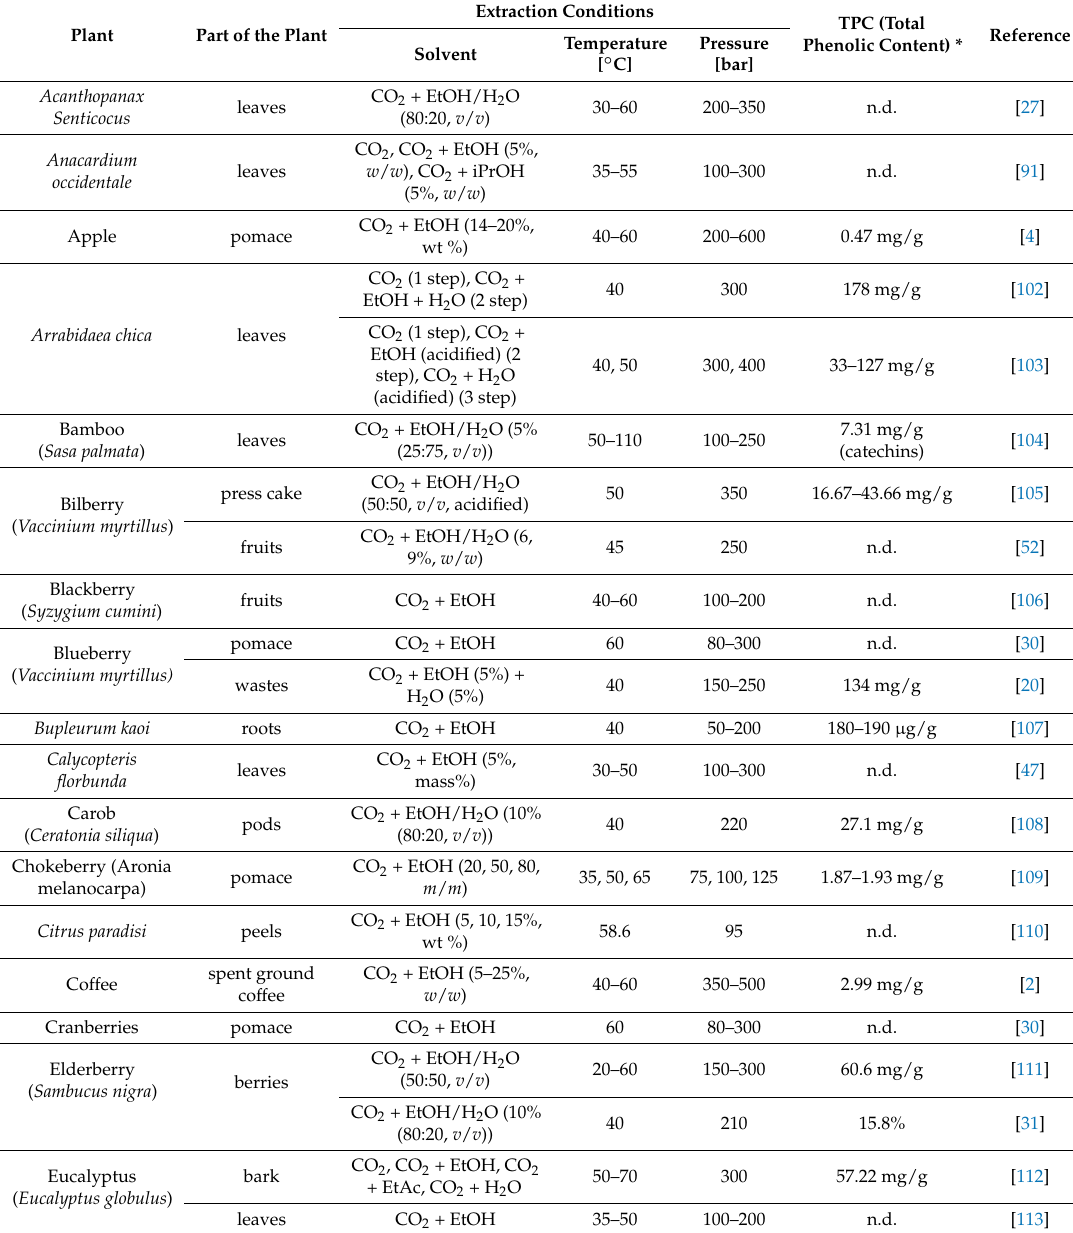
Table 2. Applications of co–solvent modified CO 2 in phenolic compounds